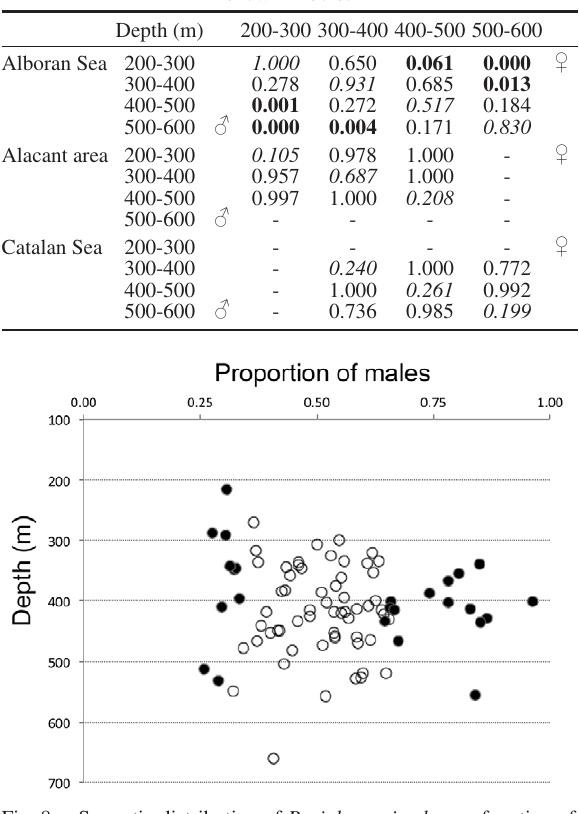
Fig. 8. – Sex ratio distribution of Pasiphaea sivado as a function of depth based on 84 valid samples. Black circles correspond to sam- ples significantly different to the expected 1:1 sex ratio, while white circles indicate no significant difference in sex